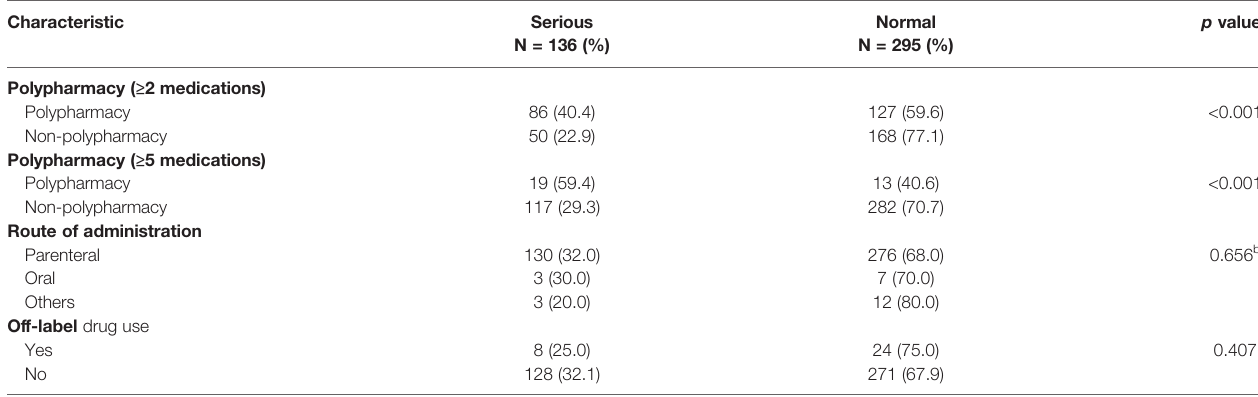
TABLE 3 | The characteristics of physicians aspect by severity of